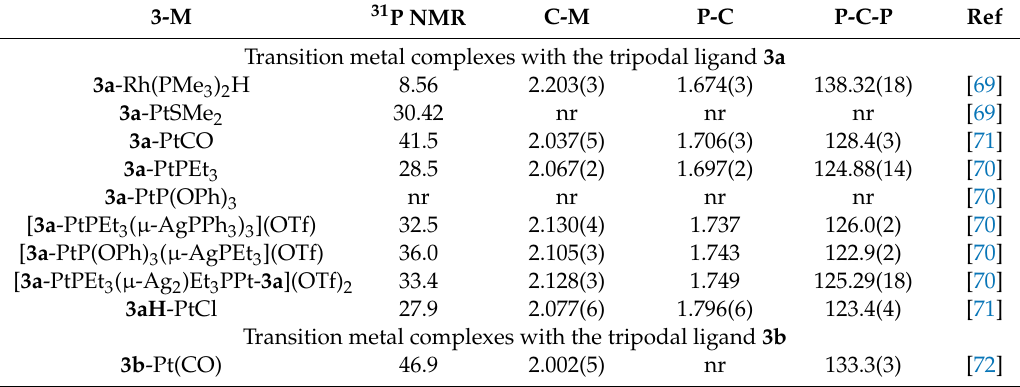
Table 3. Transition metal complexes with ortho metallated tripodal pincer ligand 3a derived from 1a and the related pincer ligand 3b and 31 P NMR shifts.